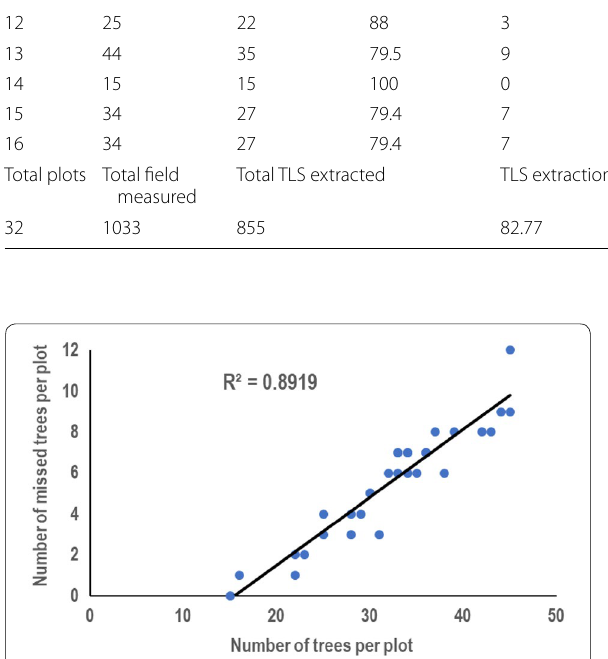
Fig. 5 Scatter plot showing the relationship between missed trees versus number of trees